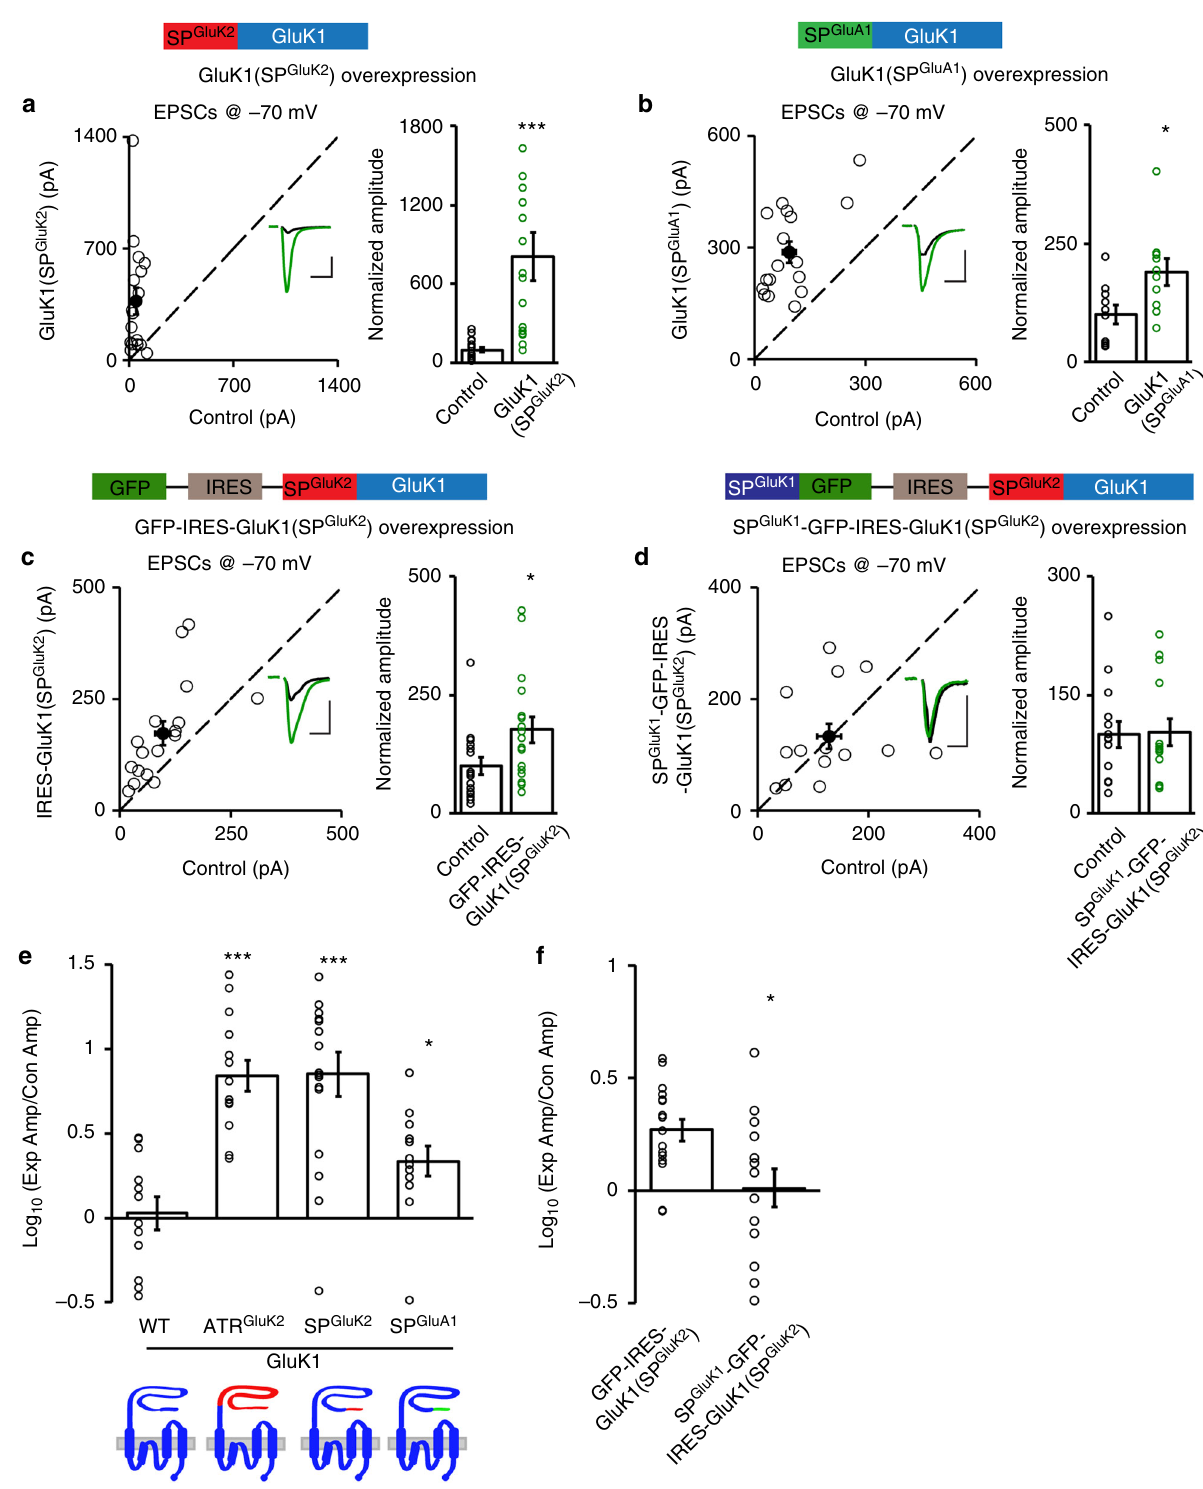
peptides was different. We fi rst used an online program SignalP 3.0 (http://www.cbs.dtu.dk/services/SignalP-3.0/) for signal pep- tide prediction and found that the signal peptide cleavage prob- ability of GluK1 is lower than that of GluK2 (Supplementary Fig. 2, GluK1: 0.532, GluK2: 0.980). Next, we inserted an HA-tag before the signal peptide of GluK1 or GluK2 to construct HA-GluK1 or HA-GluK2 (Fig. 2a and NATURE COMMUNICATIONS| (2018) 9:4879 |DOI: